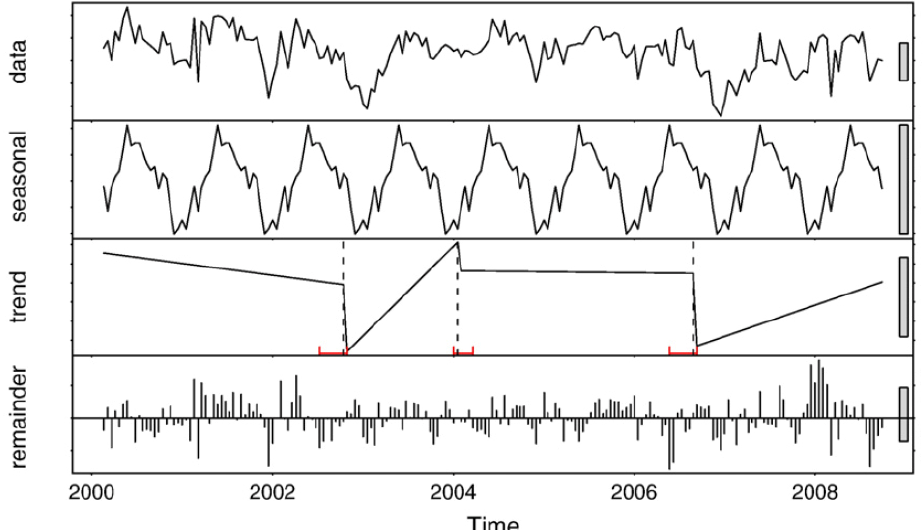
Figure 10. Example of BFAST application within a pine plantation (Australia) [13]. The fitted seasonal and trend components are shown, as well as the remaining “noise”. Three abrupt changes are detected in the trend component (in red). To aid comparisons of data ranges, solid bars are shown on the right hand side of the plots, indicating the same VI